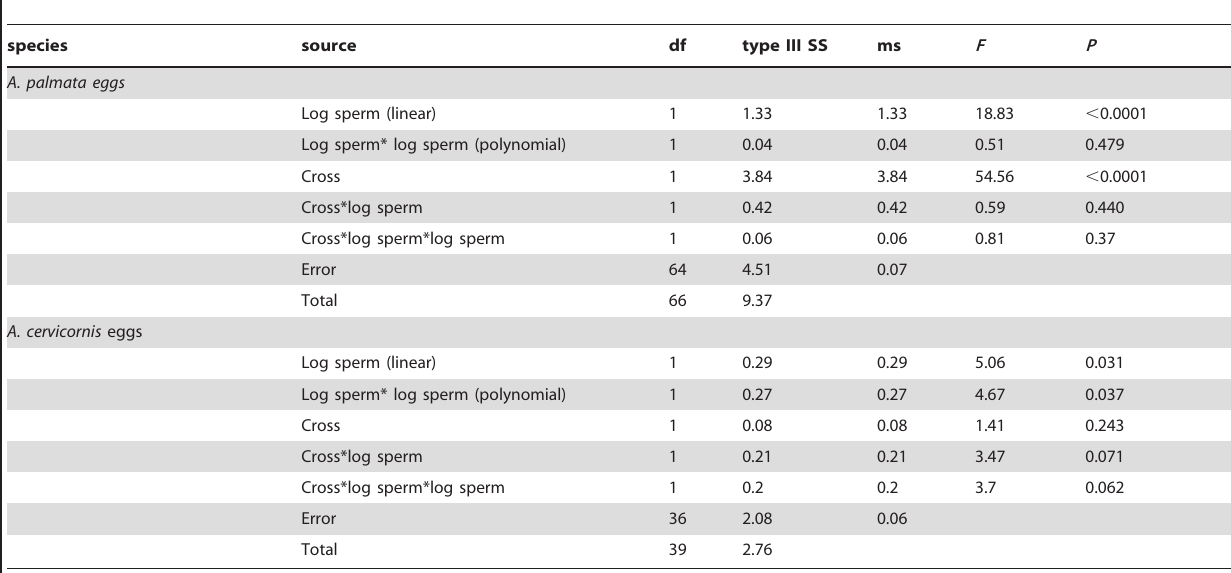
Table 1. ANCOVA results of no-choice fertilization crosses.